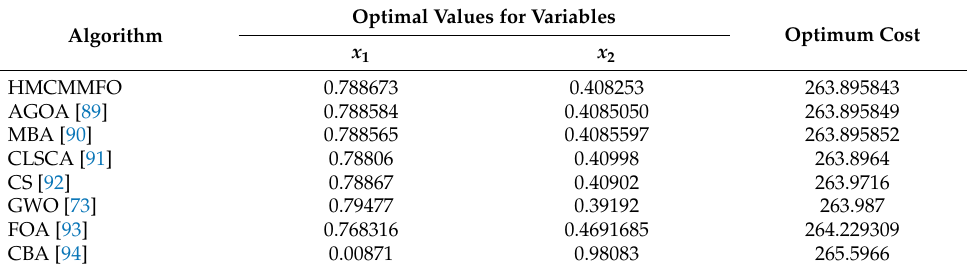
Table 10. Comparison results of the three-bar design